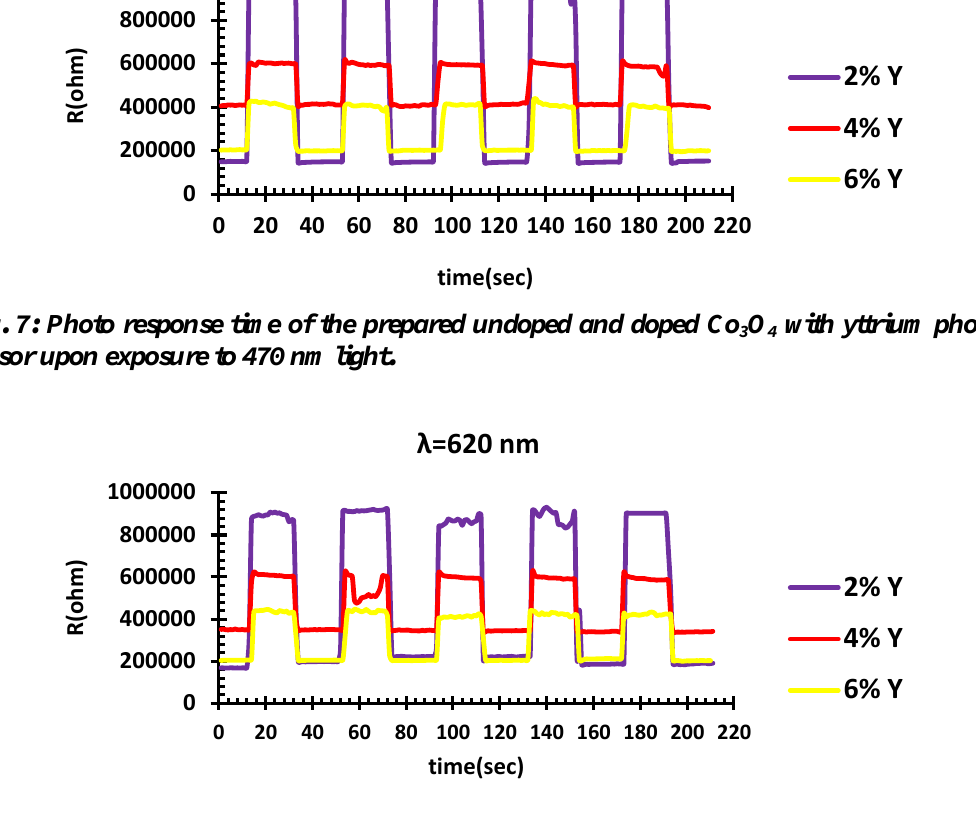
Fig. 8: Photo response time of the prepared undoped and doped Co sensor upon exposure to 620 nm light. Table 4 : Photo sensitivity as a function of wavelength for Co